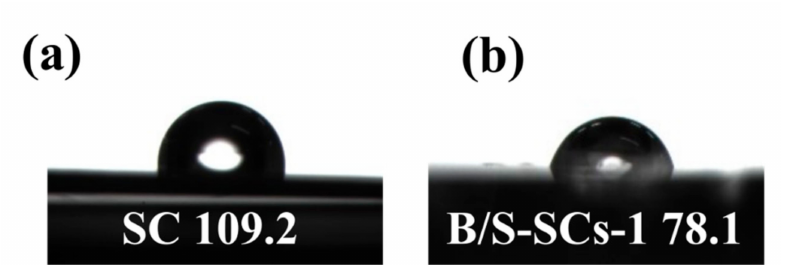
Figure 5. The contact angles formed by water drops on the surface of ( a ) SC and ( b ) B/S-SC S